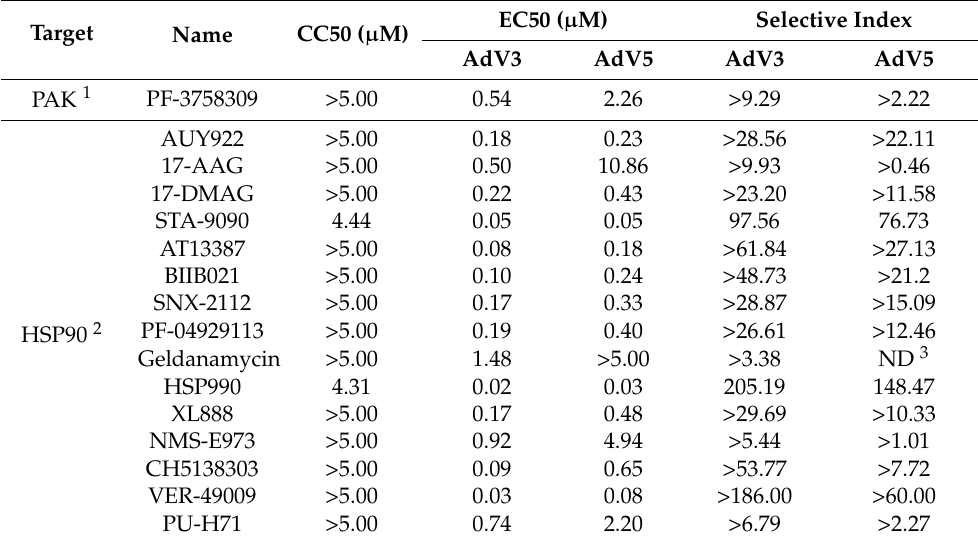
Table 1. Anti-ADV activities of hit compounds targeting cytoskeletal signaling.